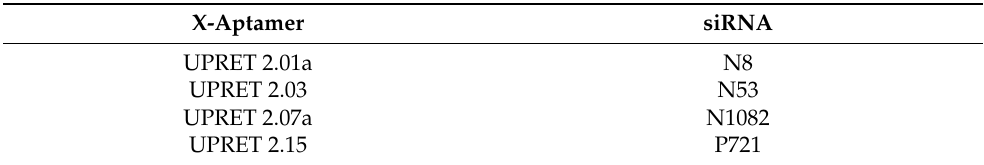
Table 1. Selected X-aptamers and siRNAs used as mixture combinations as well as for chimerization through biotin–avidin linkage followed by in vitro p.i.